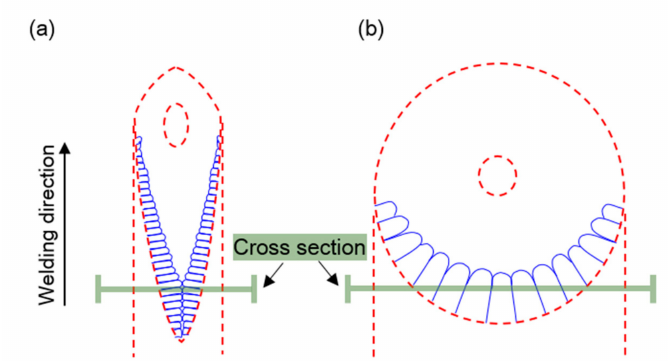
Figure 9. Comparison of the solution direction for columnar grain in fusion zone between: ( a ) high welding speed; ( b ) low welding